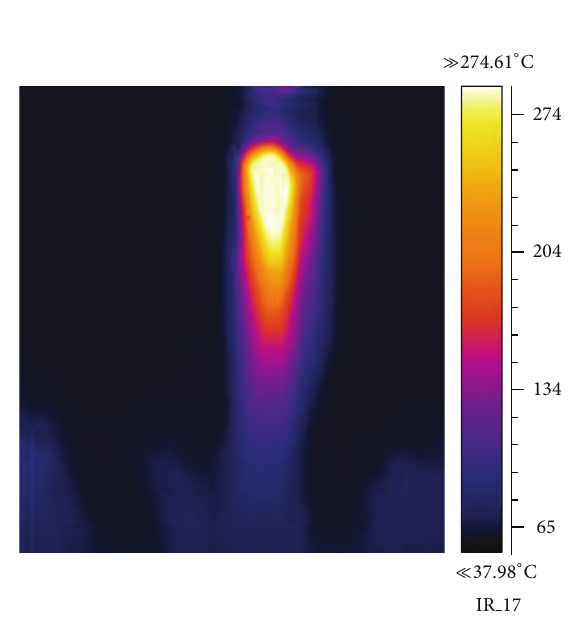
Figure 7: Thermal image of the ROI at 𝑡 = 115